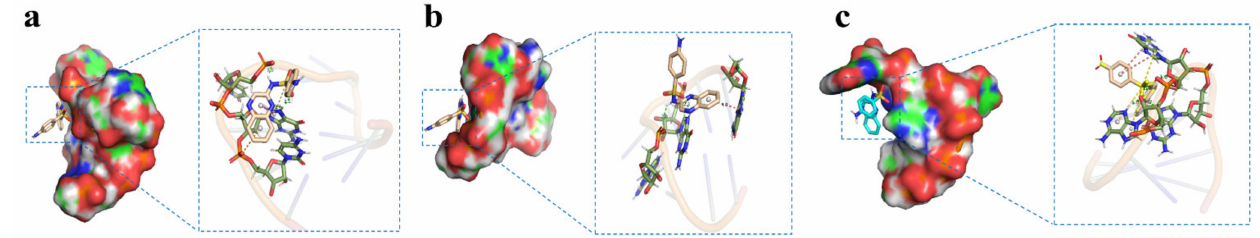
Figure 1. Predicted binding between SQX and aptamer as indicated by the surface display diagram